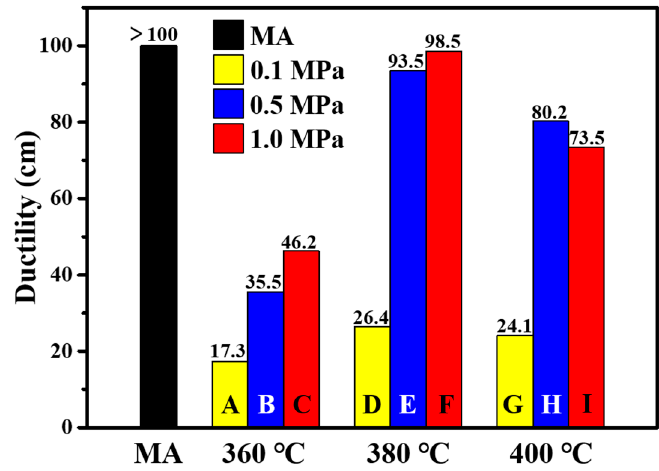
Figure 5. Ductility of MA and PPWA at 15